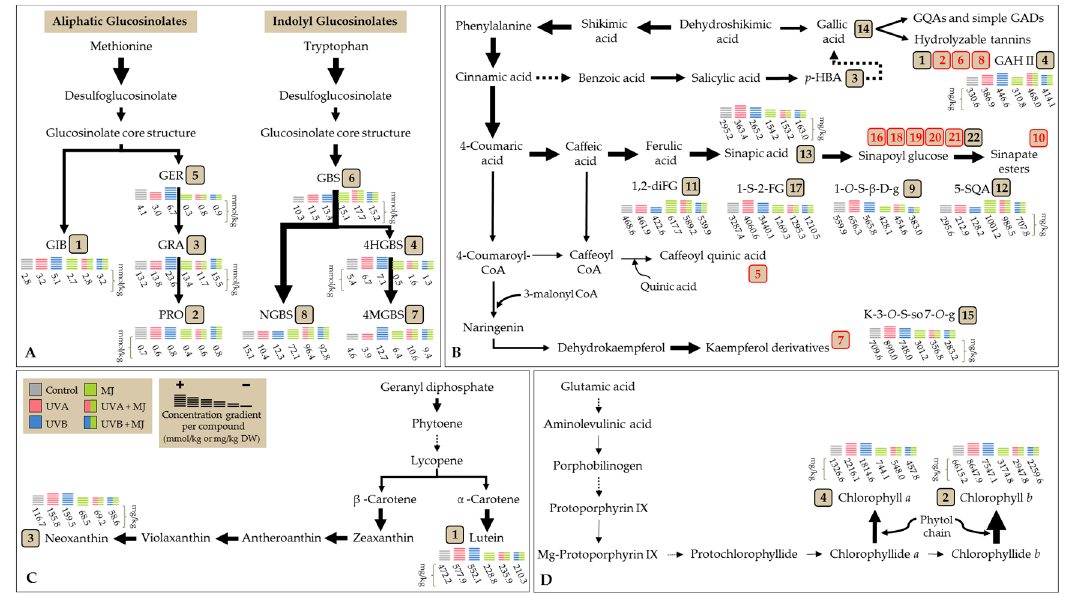
Figure 4. Accumulation of individual ( A ) glucosinolates; ( B ) phenolic compounds; ( C ) carotenoids; and ( D ) chlorophylls in broccoli sprouts treated with UV light and MJ. Identified compounds are located in their corresponding biosynthetic pathway. Dashed arrows represent multiple enzymatic steps. The numbering of compounds corresponds to the peak number assigned in Table 1 for A , Table 3 for B , and Table 5 for C and D . Numbers in red correspond to compounds whose concentration decreased or remained unaffected by all treatments compared to its control; and in black, increased. From the latter group, phenolic compounds 4, 9, 11, 12, 15, and 17 (in B ) were taken as the most representative. Concentrations (in mmol/kg DW or mg/kg DW) correspond to data presented in Table 2 for A , Table 4 for B , and Table 6 for C and D . For treatments with MJ (green), 65 mL of a 25 µM MJ solution were exogenously sprayed to broccoli sprouts every 12 h from sowing day until the 8th day after sowing. For treatments with UVA (red) and UVB (blue) lights, broccoli sprouts were exposed for 120 min to doses of 9.47 and 7.16 W/m 2 respectively, on the 7th day after sowing. Harvest of treated and non-treated sprouts occurred on the 8th day after sowing. The higher the color block, the greater the compound’s accumulation after a given treatment. Abbreviations: Dry weight (DW); Methyl Jasmonate (MJ); Ultraviolet (UV); Glucoiberin (GIB); Progoitrin (PRO); Glucoraphanin (GRA); 4-hydroxy-glucobrassicin (4-HGBS); Glucoerucin (GER); Glucobrassicin (GBS); 4-methoxy-glucobrassicin (4-MGBS),